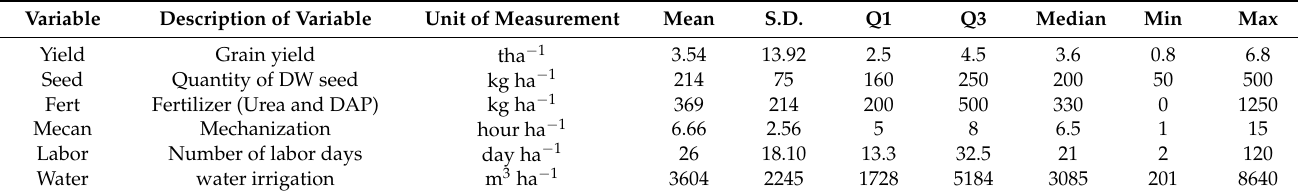
Table 3. Descriptive statistics of input–output variables for DEA.